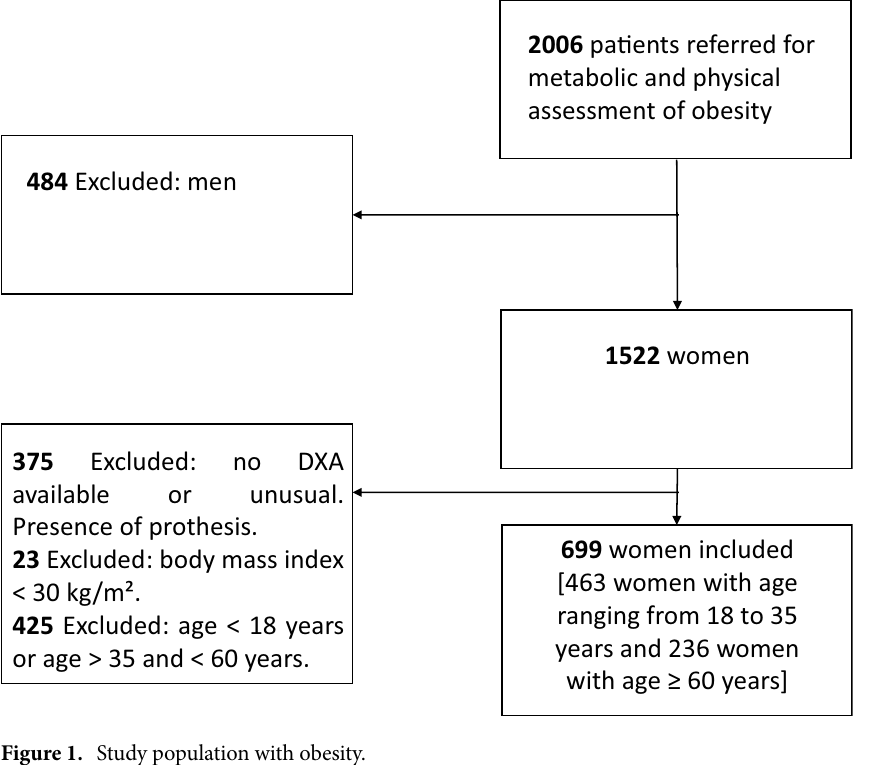
Figure 1. Study population with